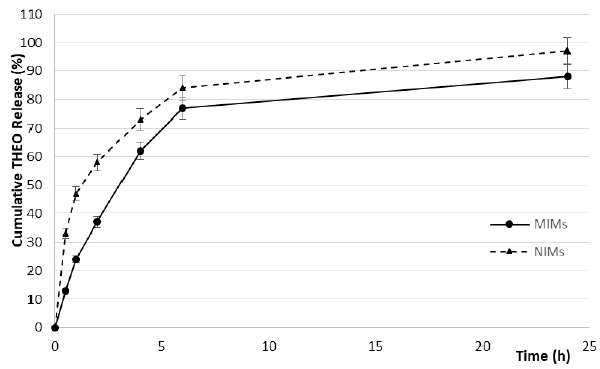
Figure 2. THEO release profiles.